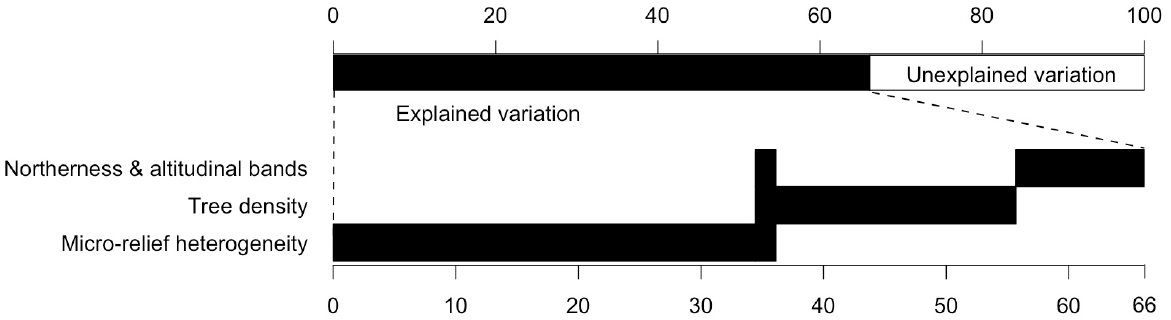
Figure 5. Partitioning of the variation of total species richness between the explanatory variables tree density, a combined spatial variable based on northernness and altitudinal bands, and micro-relief heterogeneity. Overlapping bars indicate jointly explained variance [%]. Non-overlapping parts depict explained variance explained only by a single variable.